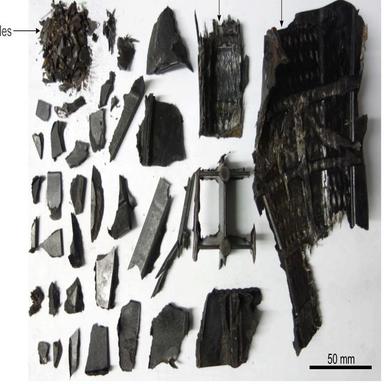
Example of liberated polymer particles (progenies of feed B33 on a DIN A4 sheet).